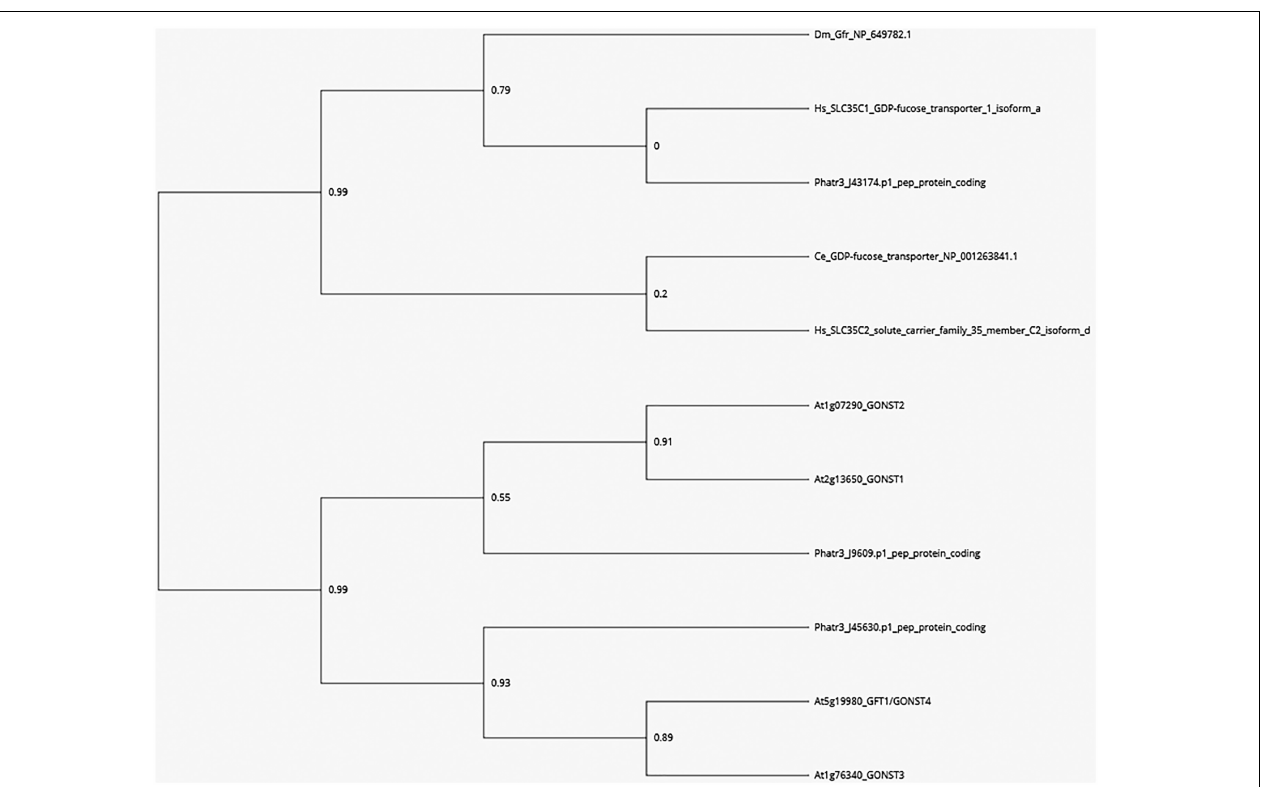
FIGURE 1 | Phylogenetic tree of GDP- L -fucose and GDP- D -mannose transporters from eukaryotes based on Rautengarten et al. (2016) and Ebert et al. (2017). A BLASTP search was carried out in the sequence data of P. tricornutum using the GOLGI-LOCALIZED NUCLEOTIDE SUGAR TRANSPORTER GONST1, GONST2, GONST3, and GFT1/GONST4 amino acids sequences of A. thaliana . Three encoding sequences corresponding to the Phatr3_J43174, Phatr3_J45630, and Phatr3_J9609 were identified. These A. thaliana and P. tricornutum sequences were compared to the functionally characterized animal GDP-fucose transporters from H. sapiens (NP_060859.4, SLC35C1_GDP-fucose transporter 1 isoform a), C. elegans (NP_001263841.1, GDP-fucose transporter), D. melanogaster (NP_649782.1, Gfr) and also the H. sapiens SLC35C2 (NP_001268386, solute carrier family 35 member C2 isoform d). A phylogenetic analysis and tree